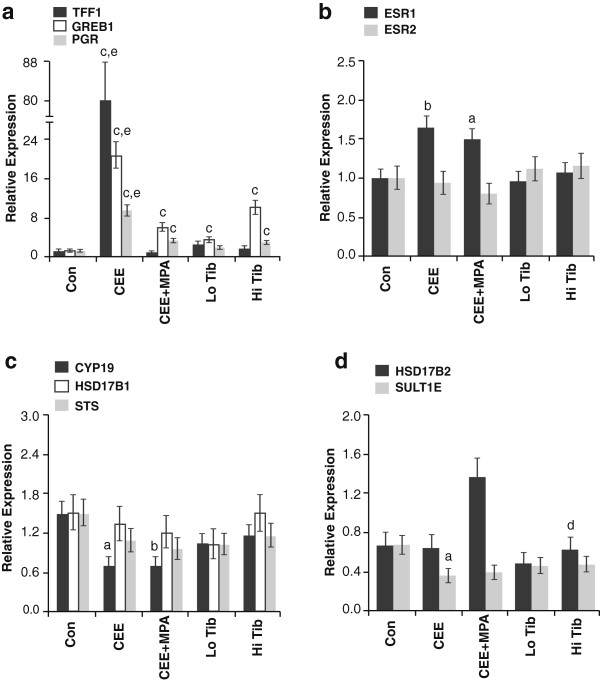
Hormone therapy effects on gene markers related to ER expression and activation. (a) Hormone therapy effects on gene markers related to oestrogen receptor (ER) activation; (b) ER expression; (c) estradiol synthesis and bioactivation; and (d) estradiol deactivation. mRNA expression levels were determined by quantitative PCR. Vertical lines indicate 90% confidence interval. Letters indicate significant differences compared with control (P < 0.05a, P < 0.01b, P < 0.001c) and conjugated equine estrogens plus medroxyprogesterone acetate (CEE + MPA) (P < 0.01d, P < 0.001e) groups.